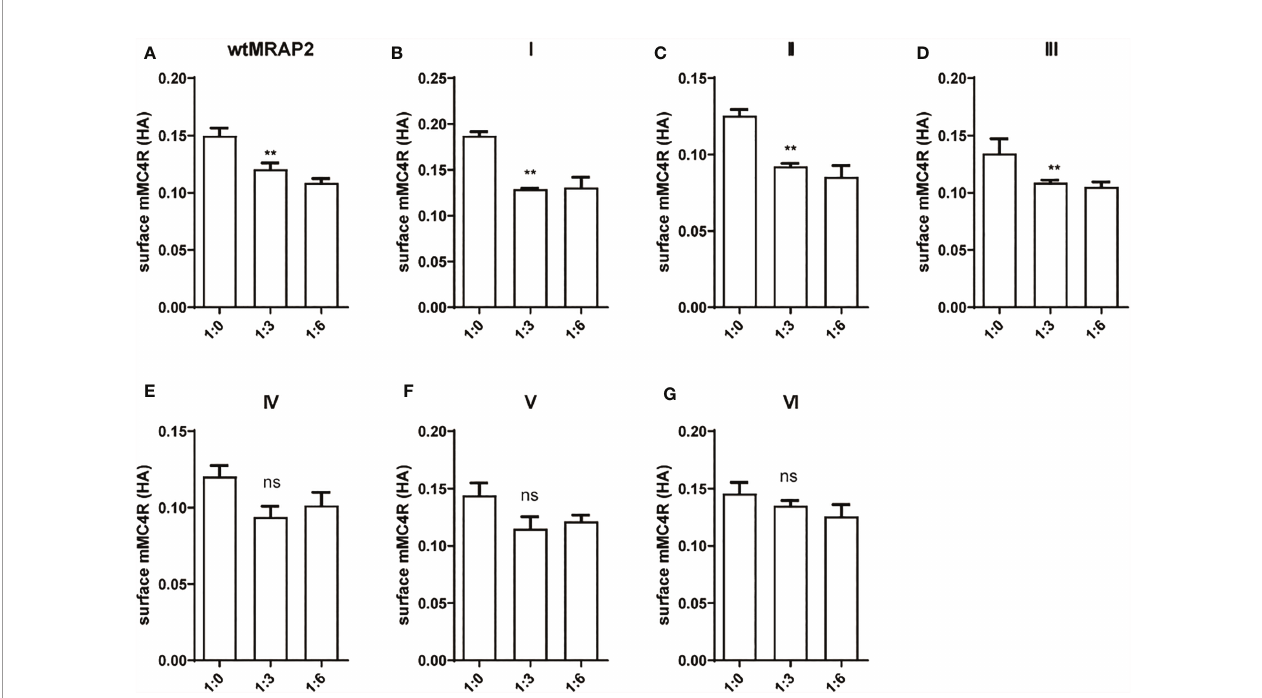
FIGURE 5 | Surface traf fi cking measurement of melanocortin-4 receptor (MC4R) by melanocortin receptor accessory protein 2 (MRAP2) variants. Surface expression of MC4R was measured using ELISA in HEK293T cells transfected with 3HA-MC4R and different amounts of 2FLAG-MRAP2 or 2FLAG variants (A – G) . One-way ANOVA with post-hoc Tukey ’ s test. ns (no signi fi cant change), ** p < 0.01. Each data column represents the mean ± SEM of three replicates ( N =